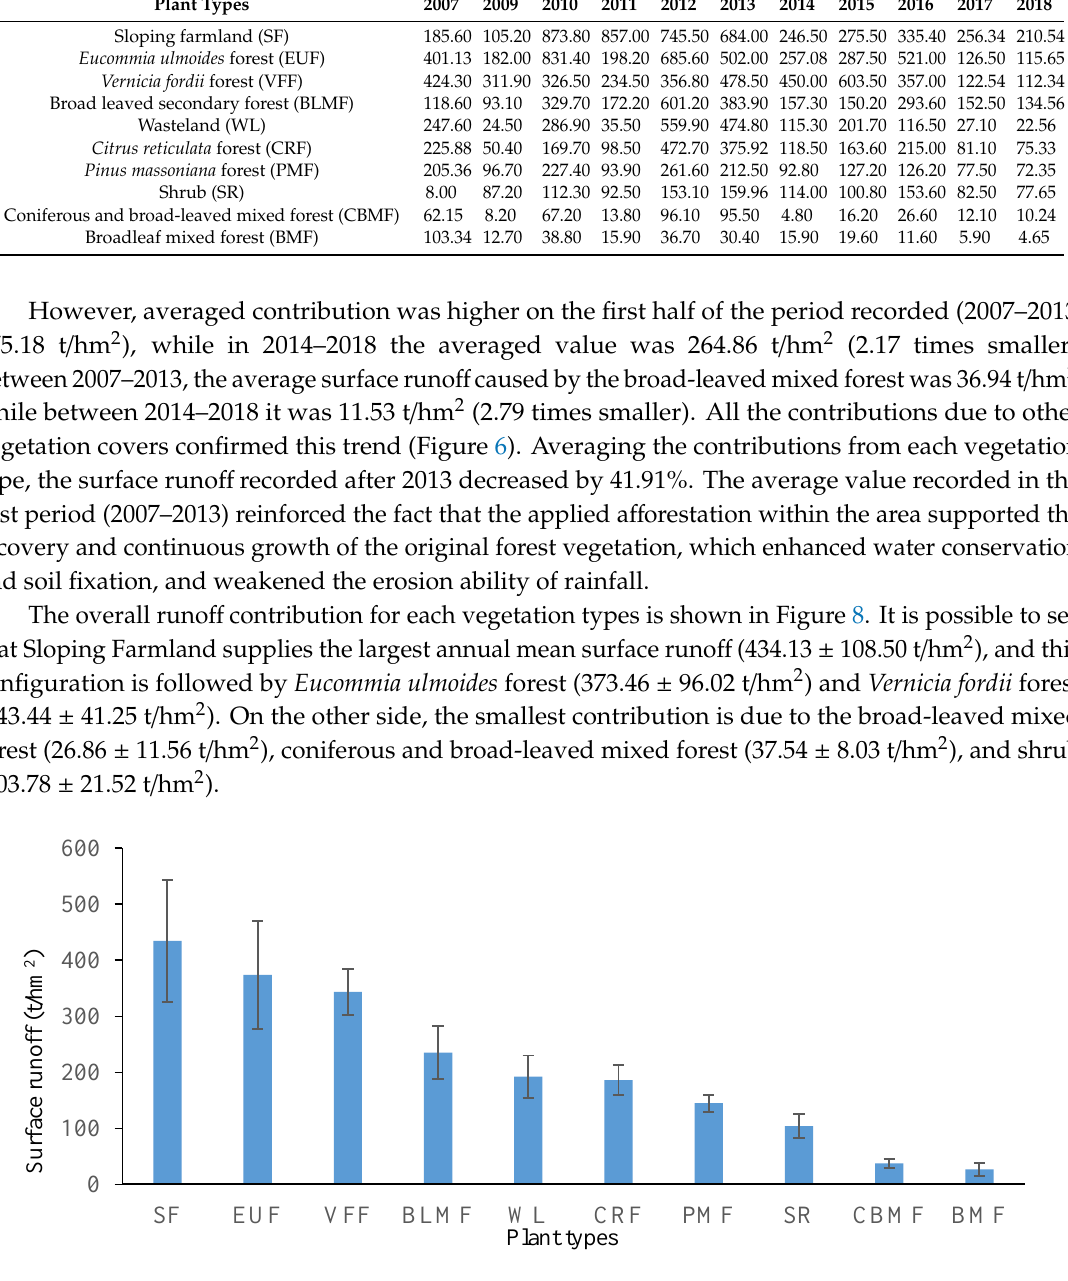
ff of di ff erent vegetation